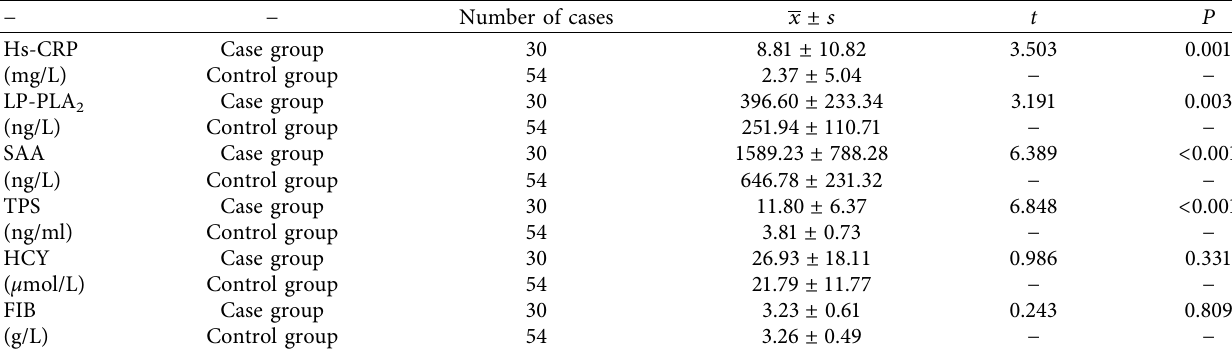
Table 3: Comparison of each biomarker index between the case group and the control group.